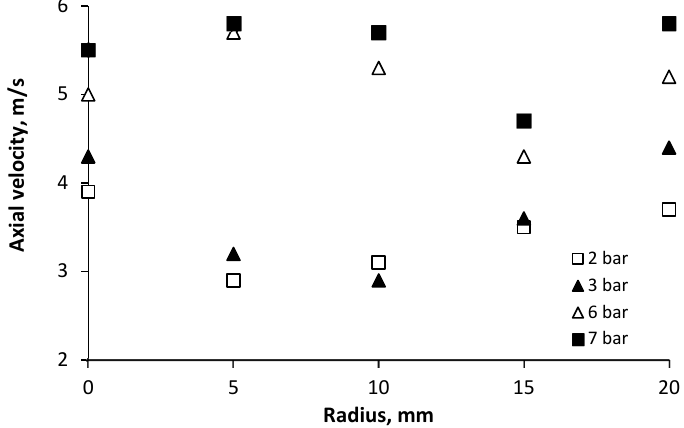
Figure 7. Axial droplet velocity vs radius for different water pressures.